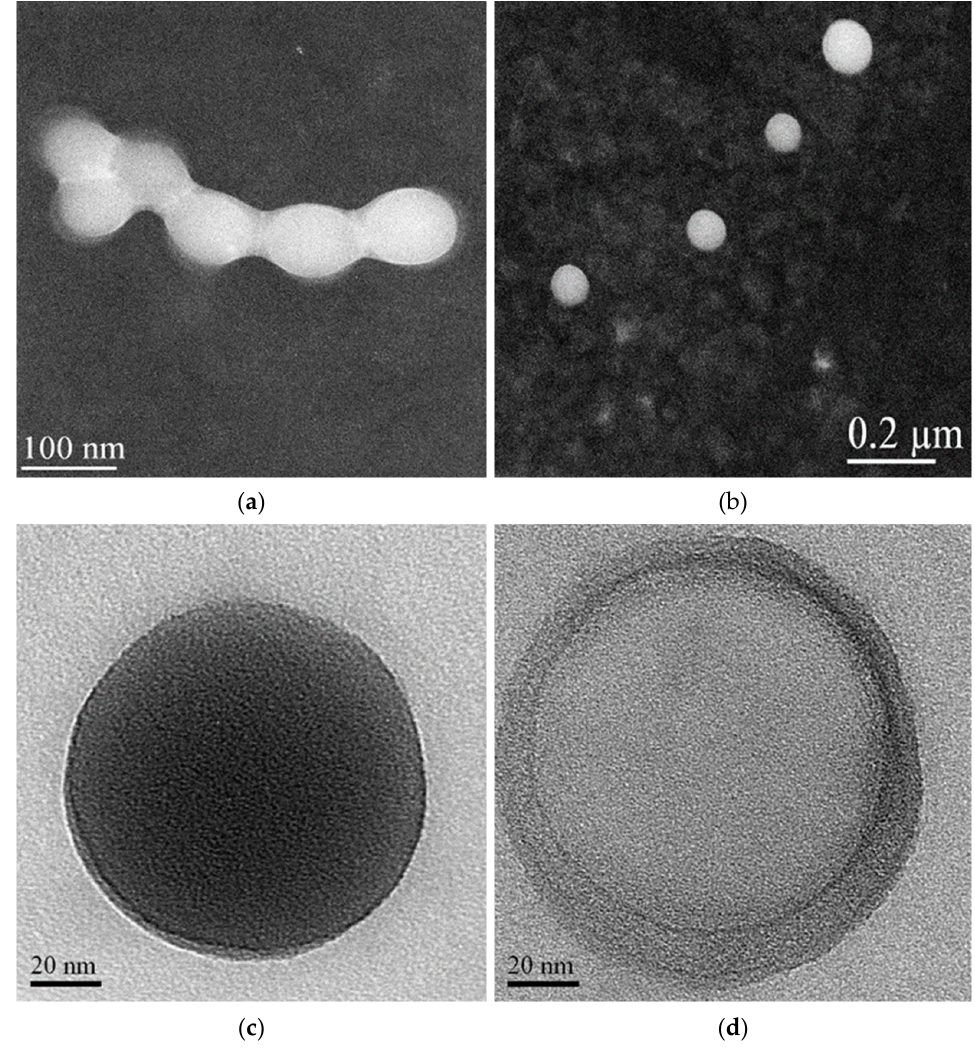
Figure 10. STEM images of lyophilized IDE/ACyD8-NPs before ( a ) and after redispersion ( b ). The NPs observed at higher magnification showed both matrix structure ( c ) and nanoreservoir structure ( d ).